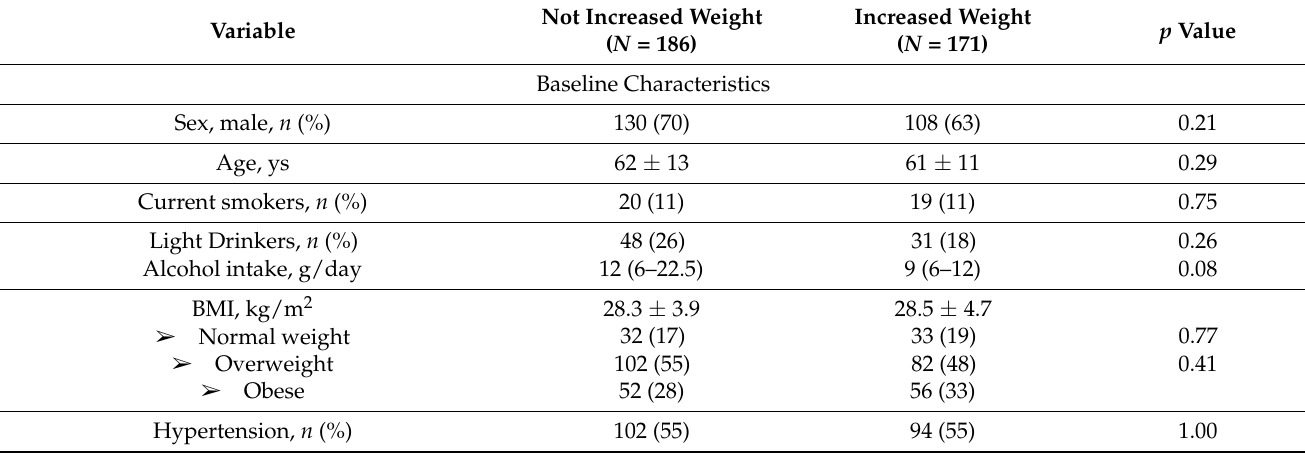
Table 1. Univariate analysis of factors determining weight gain in the entire